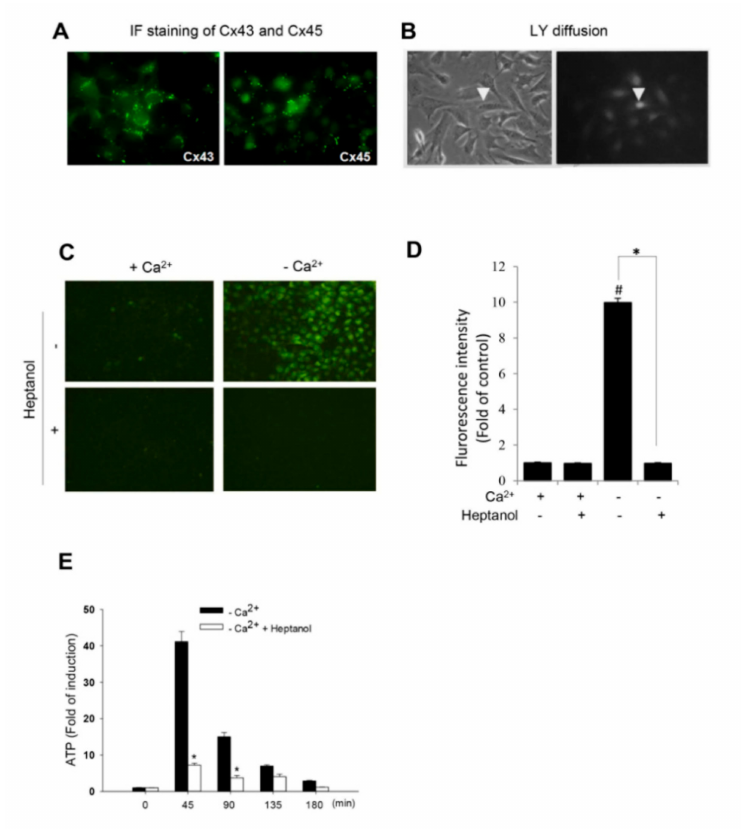
Figure 1. Induction of hemichannel opening by removal of extracellular Ca 2 + . ( A ) Immunofluorescent staining of Cx43 and Cx45 in As4.1 cells. As4.1 cells were stained for expression of Cx43 and Cx45. Note the localization of Cx43 and Cx45 in both membrane and cytoplasm. Magnification, X320. ( B ) Di ff usion of LY following single cell injection. LY was injected into single As4.1 cell (arrow head) and the di ff usion of LY from the injected cell to neighboring cells was photographed (right image). Magnification, X320. ( C , D ) E ff ects of extracellular Ca 2 + depletion on hemichannels activities. ( C ) E ff ects of Ca 2 + depletion on cellular uptake of LY. As4.1 cells were pretreated with or without 3 mM heptanol for 15 min. After that, they were exposed to either normal or Ca 2 + -free culture medium that contained 0.05% LY in the presence of the same concentrations of heptanol for an additional 20 min. The influx of LY was photographed (Magnification, X200). The fluorescent intensity of the cells in C was measured with ImageJ and expressed as relative unit against control (mean ± SE, n = 20; # p < 0.01 versus control, * p < 0.01). Data shown areone representative result out of four separate experiments. ( E ) Ca 2 + depletion on extracellular release of ATP. As4.1 cells were exposed to Ca 2 + -free culture medium in the presence or absence of 3 mM heptanol for the indicated time intervals. Cell supernatants were collected and quantitated for ATP concentration. Results are expressed as fold induction relative to control (mean ± SE, n = 4). * p < 0.01 versus-Ca 2 +